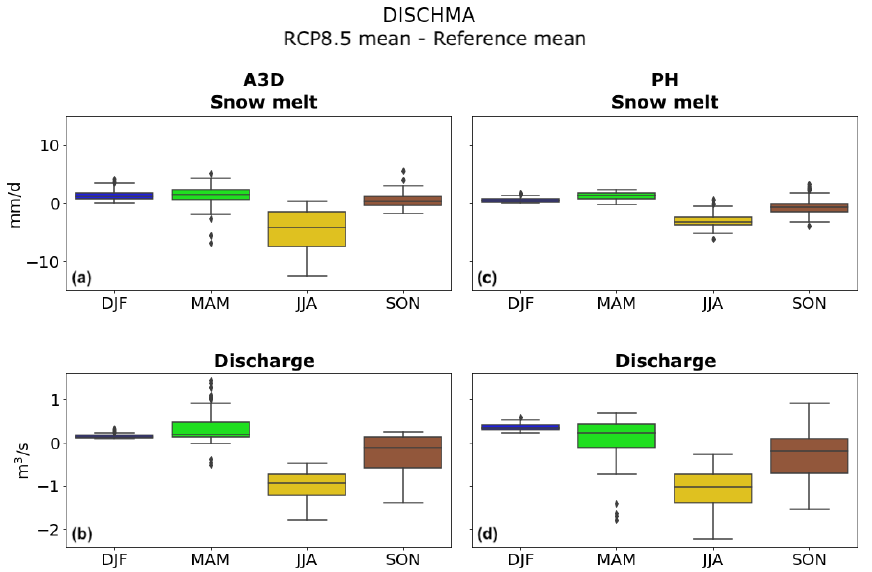
Figure 12. Boxplot illustrating the difference between the 2080–2090 RCP8.5 scenario mean and the reference mean (1990–2000) for snowmelt (a) and discharge (b) predicted by A3D (a, b) and PH (c, d) for the Dischma